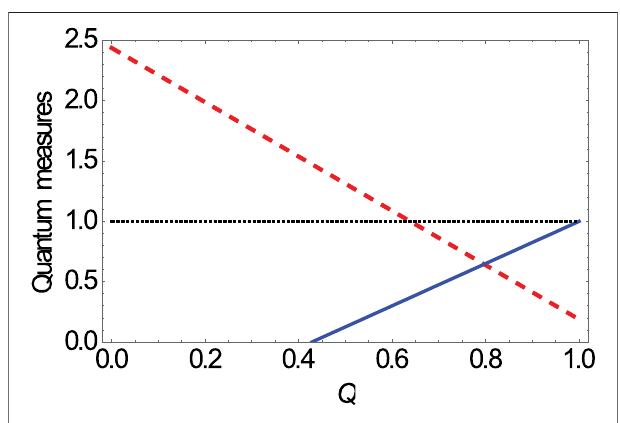
FIGURE 1 | (Color online) Quantum measures {GME (blue solid line) and GMSinequality(reddashed line)}asafunctionofthestateparameter Q ,when (cid:8)(cid:8) √ α is equal to 2 /2. Here, the value of the black dashed line is equal to 1.